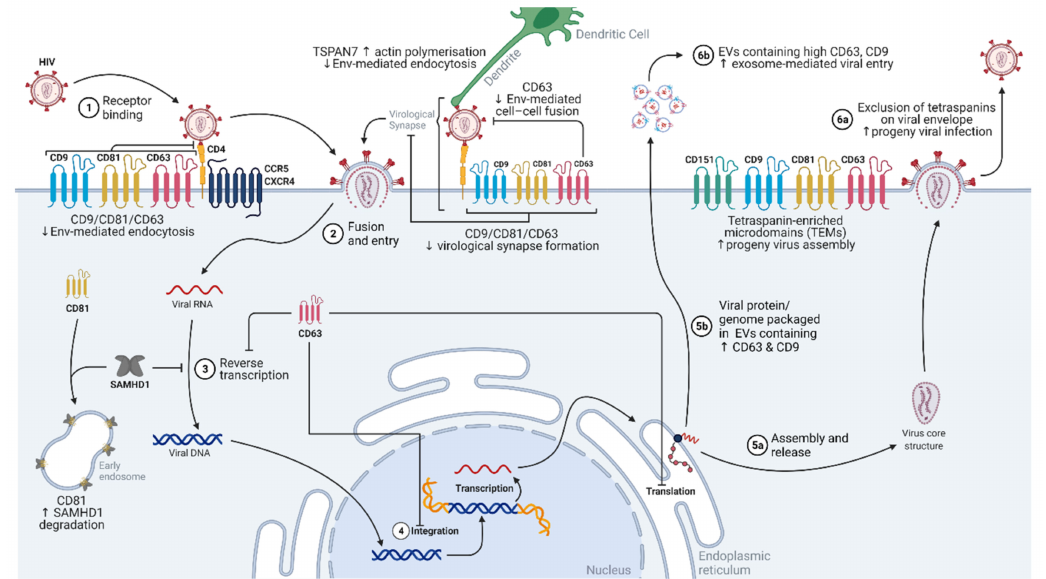
Figure 2. Diagram showing the contribution of tetraspanins in the HIV-1 replication cycle. CD9, CD81, and CD63 suppress HIV-1 viral entry, either through canonical endocytosis or the virological synapse. TSPAN7 also suppresses HIV-1 entry into dendritic cells by enhancing intracellular actin polymerization. Within the cell, CD81 binds to and promotes the degradation of SAMHD1, enhancing reverse transcription. CD63 is also associated with the inhibition of HIV-1 reverse transcription, integration, and translation. Tetraspanin-enriched microdomains (TEMs) serve as anchor sites for HIV-1 progeny assembly, while their integration in viral progeny envelopes is excluded. EVs with higher expressions of CD63 and CD9 contain the HIV-1 genome and/or viral proteins, and these EVs also have enhanced entries into target cells. Abbreviations: HIV, human immunodeficiency virus; CCR5, C-C chemokine receptor type 5; CD4, cluster of differentiation 4; CD9, cluster of differentiation 9; CD63, cluster of differentiation 63; CD81, cluster of differentiation 81; CD151, cluster of differentiation 151; CXCR-4, C-X-C chemokine receptor type 4; Env, envelope protein; EVs, extracellular vesicles; SAMHD1, sterile alpha motif (SAM) domain and histidine-aspartic domain (HD)-containing protein 1; TSPAN7, tetraspanin 7; vRNP, viral